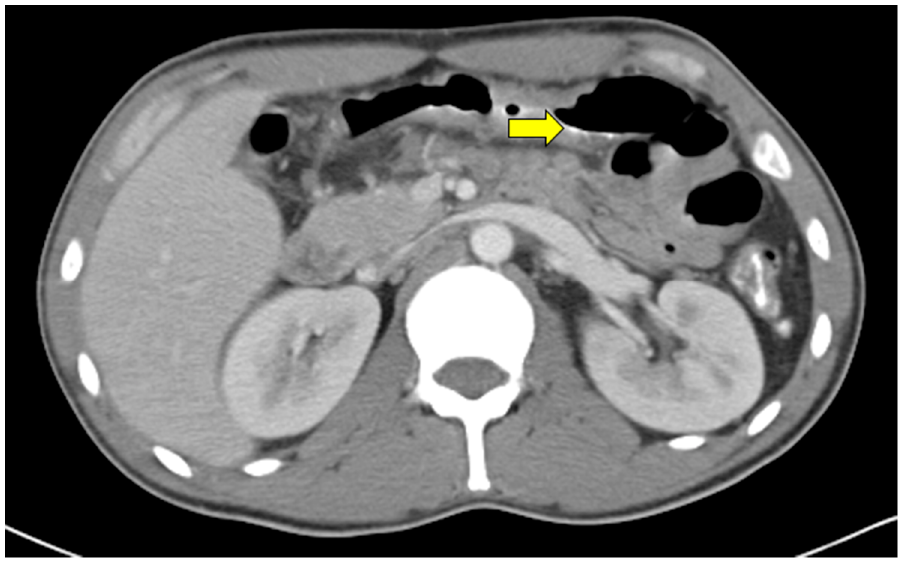
Figure 1. Abdominal computed tomography scan. The yellow arrow points to the wall thickening of the transverse colon.